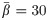
Global robustness of crosstalk patterns from the CLASH interactome with increasing degrees of transcriptional heterogeneity.For each susceptibility sextile, the marking above the arrow reports the fraction of crosstalk interactions that are preserved upon increasing the degree of TH. The last column reports the fraction of interactions that are conserved passing from the lowest to the highest degree of TH. Results are obtained by averaging over 100 independent TH realizations, assuming high BH and mean miRNA transcription rate β¯=30 (deep in the susceptible regime). Different intermediate values of β¯ return qualitatively identical scenarios.